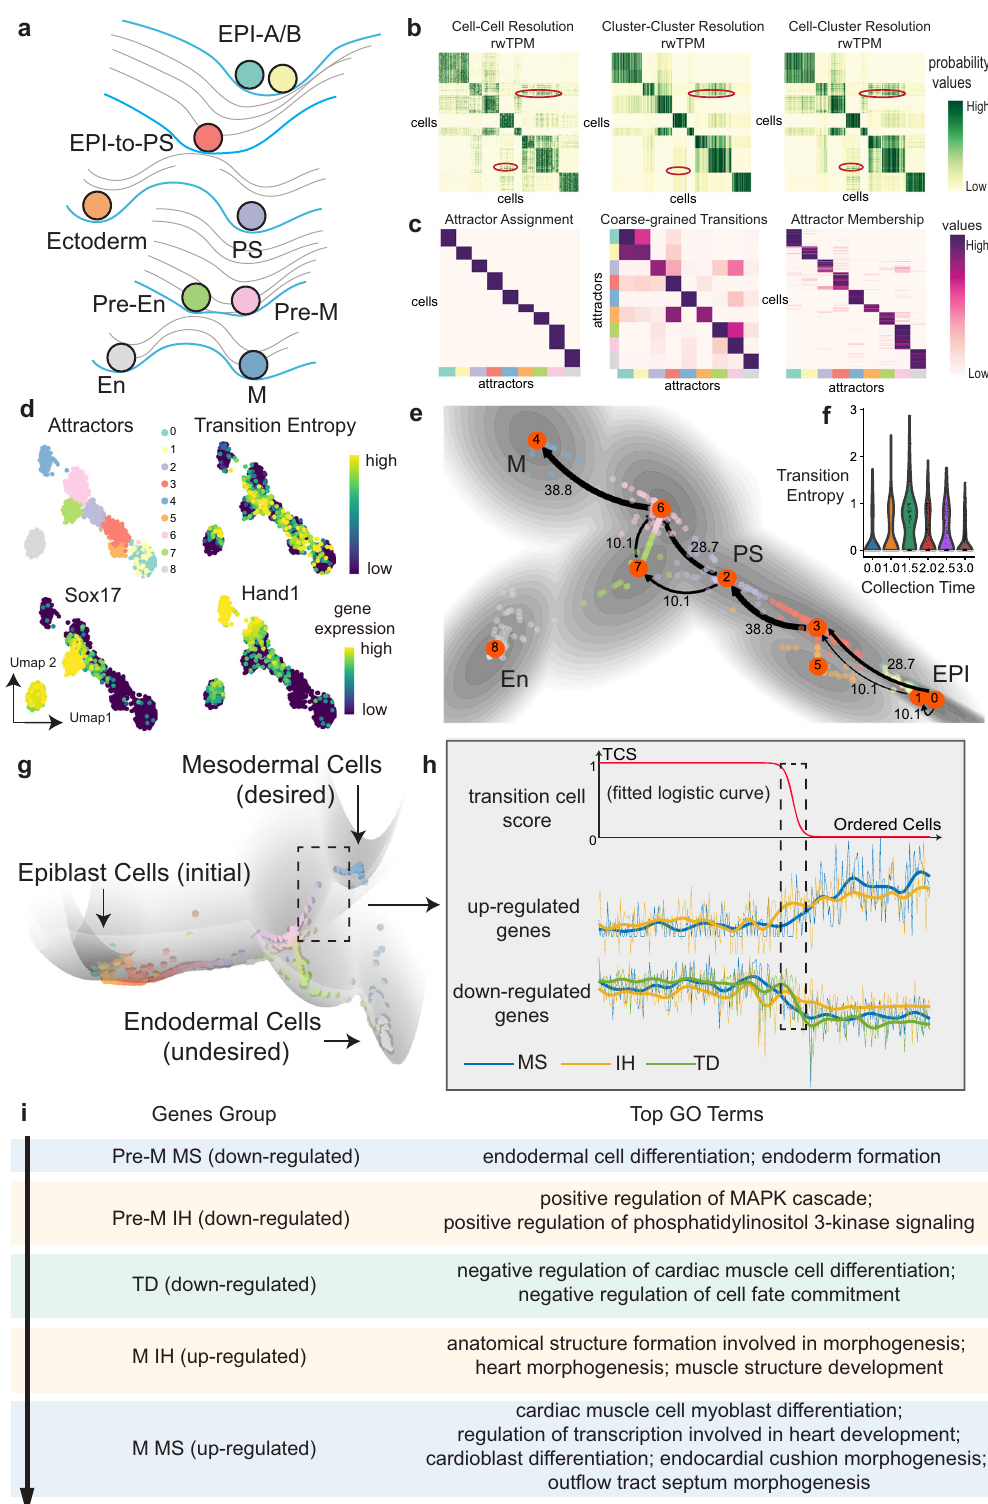
inferred dynamical manifold also suggests that certain transition cells in the attractors of pDCs originate directly from multi-potent progenitor (MPP) cells (yellow balls, Supplementary Fig. 13). MuTrans resolves the details in B cell differentiation, capturing the transition cells from Pro-B toward Pre-B basins (Supplementary Fig. 13 and Supplementary Table 7). Downstream analysis